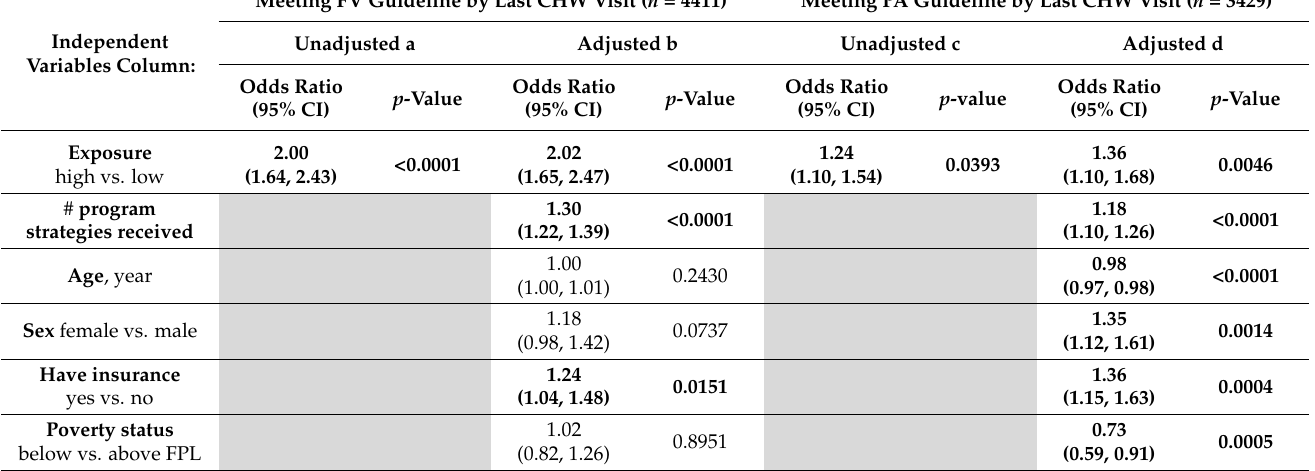
Table 4. TSSC program effect on meeting FV and PA guidelines based on logistic regression analysis ( n =